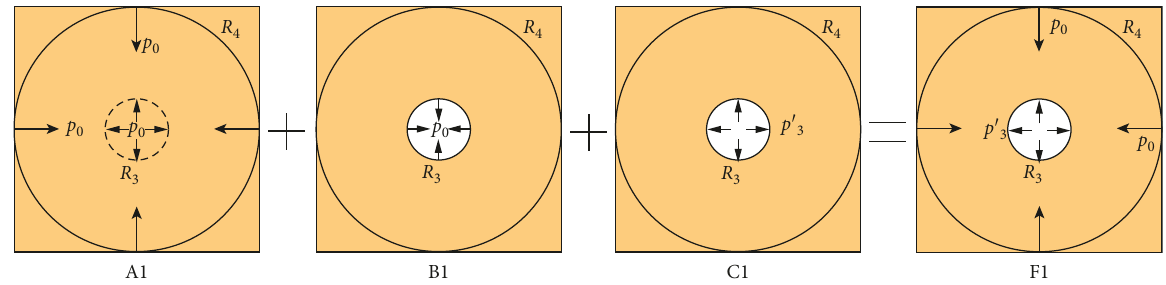
Figure 7: Wellbore stress components under the condition of uniform stress.